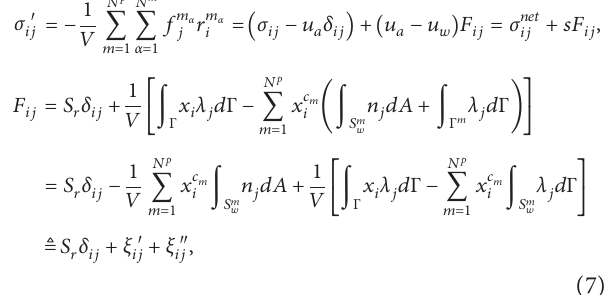
Figure 4: Influence of suction on resilient modulus ( ψ 60 in series 1 tests; ψ m � 100, 150, and 250 in series 2 tests. q is the cyclic stress.) (from